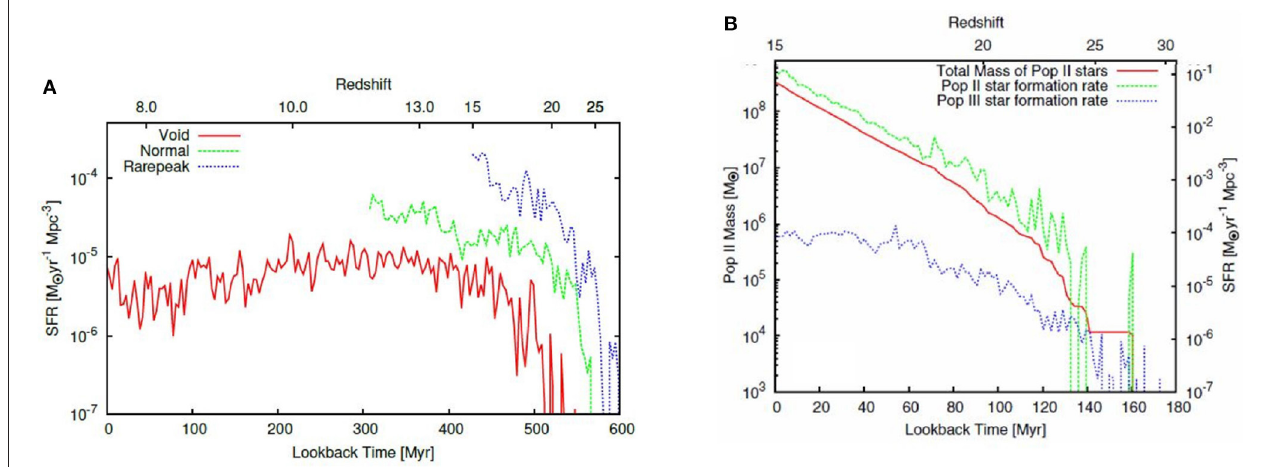
FIGURE 9 | Star formation histories in the Renaissance Simulations . Lookback time is respect to the end of the simulation. Evolutionary time increases from right to left. (A) The volume-averaged Population III star formation rate density in Rarepeak, Normal, and Void regions. Due to the presence of a strong Lyman-Werner background, the onset of Pop III star formation is delayed, but begins earlier in denser regions. The curves end when the simulations were terminated. Reproduced by permission of the American Astronomical Society, Figure 1 from Xu et al. (2016a), (B) Pop III and Pop II star formation rates in the Rarepeak simulation. Pop II quickly overtakes Pop III. Reproduced by permission of the American Astronomical Society, Figure 2 from Xu et al. (2013).